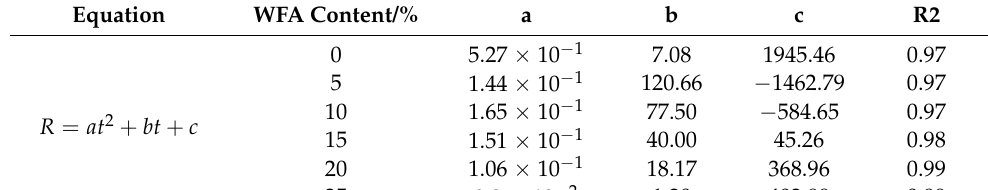
Figure 9. The mechanical strengths of cement paste with different dosage of waste fly ash. ( a ) Flexural strength, ( b ) Compressive strength.